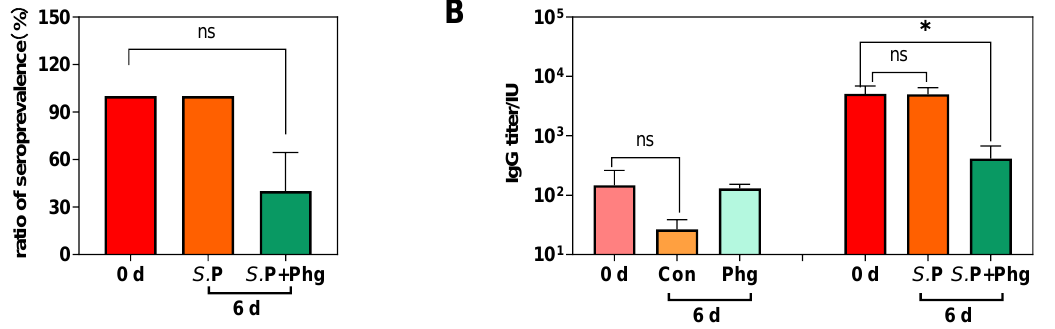
Figure 4. Phage CKT1 reduced the Salmonella -specific antibody IgG level. ( A ) The ratio of positive Salmonella antibodies in serum. 0 d, the serums of Group 1 at 0 d; S. P, the serum of S. P at 6 d; S. P + Phg, the serums of S. P + Phg at 6 d. ( B ) Salmonella -specific IgG level in serum. Con, the control group; Phg, the only phage treated group. Means of results from five independent assays are shown, and error bars represent the standard deviations. ns, p > 0.05 (Mann – Whitney test); * p < 0.05.